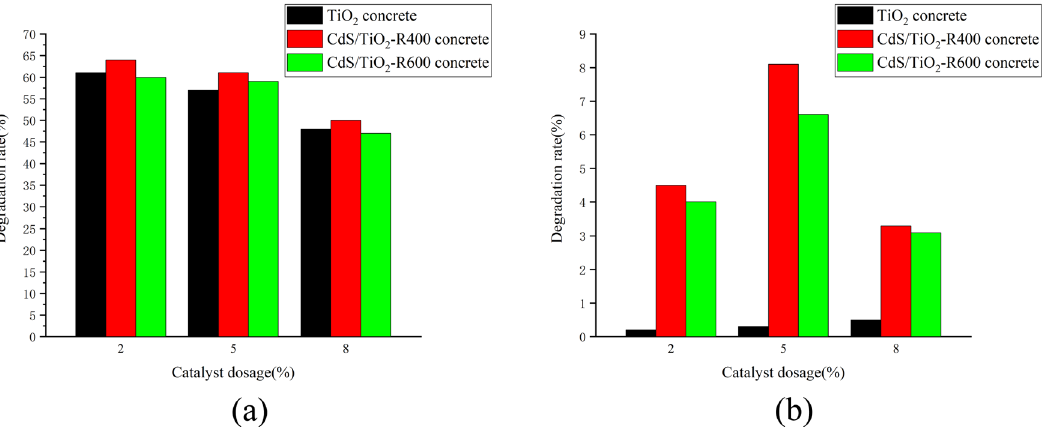
Figure 5: Photocatalytic e ffi ciency of photocatalytic concrete with di ff erent catalyst types. ( a ) Ultraviolet light ( b ) visible